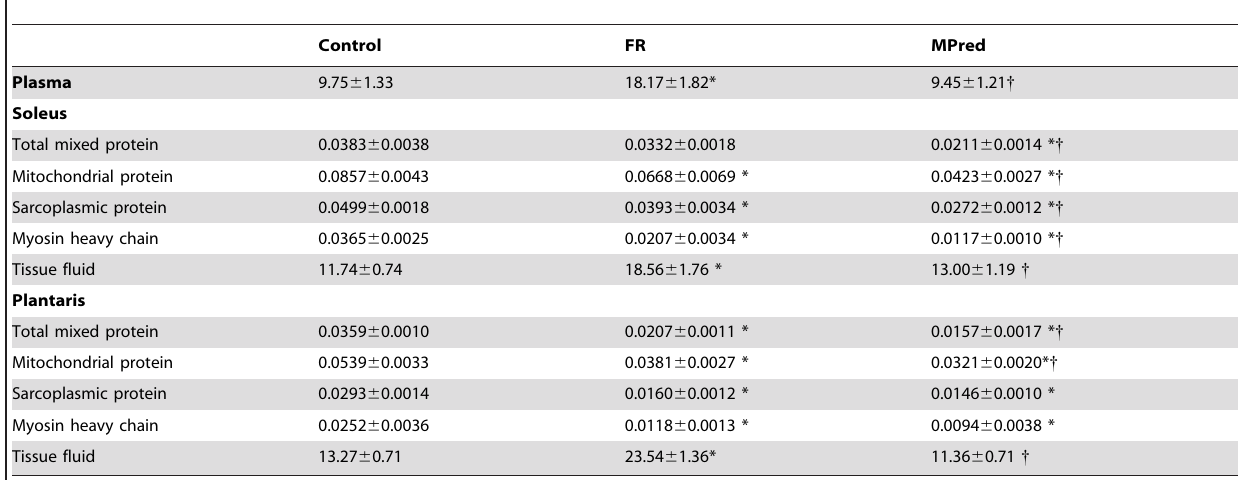
Table 2. Enrichment of [ 13 C 6 ] phenylalanine in plasma, muscle proteins and tissue fluid